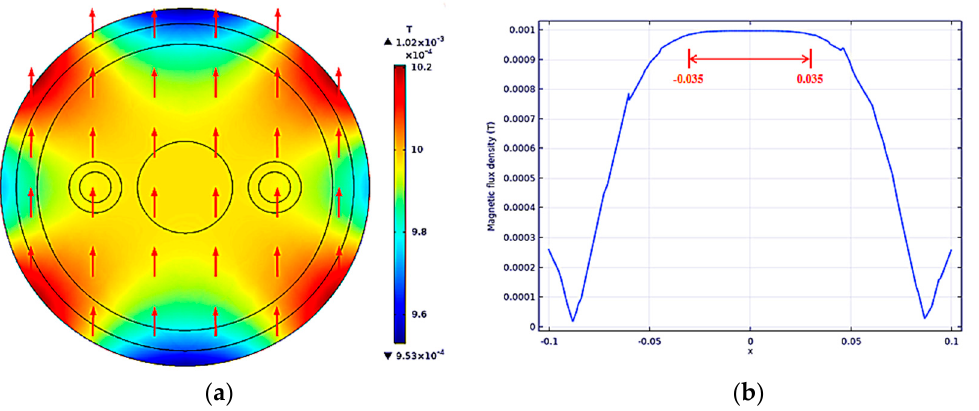
Figure 5. The uniform magnetic field distribution in the section was measured: ( a ) Uniform magnetic field distribution; ( b ) magnetic flux density at each point on the X-axis.